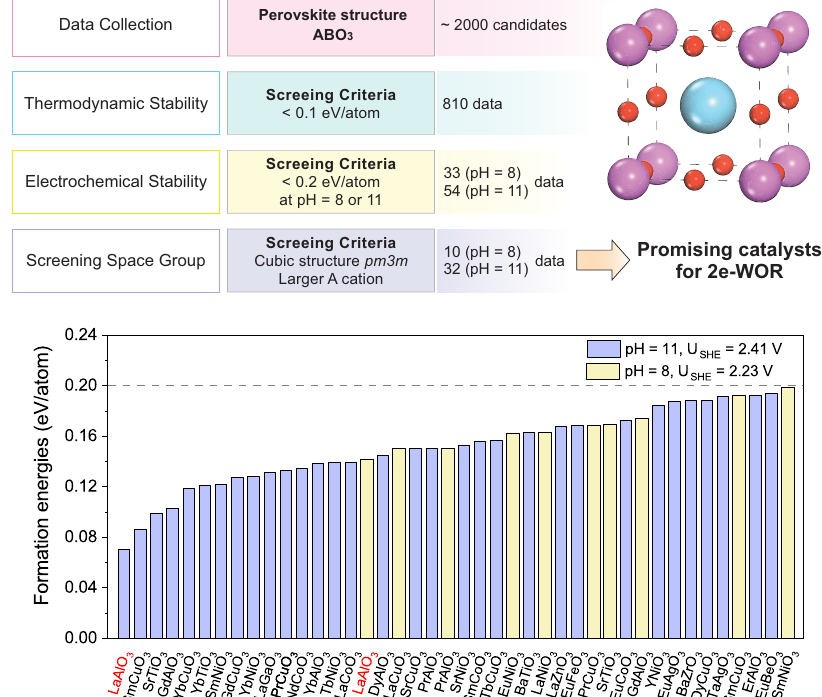
Fig. 1 | Computational screening to discover the most stable perovskite oxide under different pH conditions. Filtering stable ABO 3 perovskite structures based